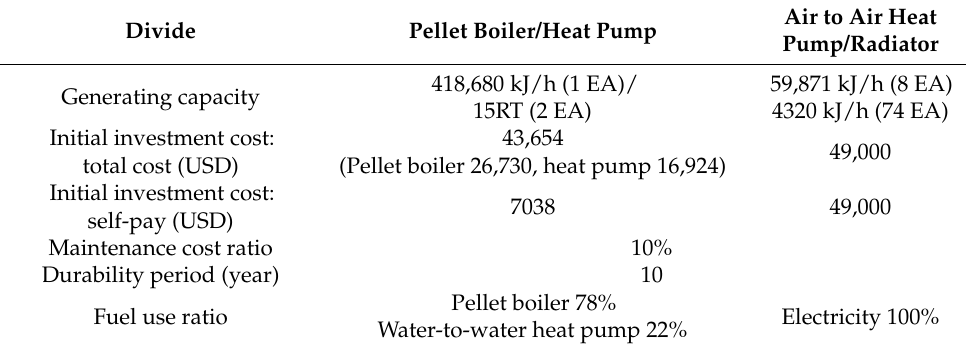
Table 7. Factors involved in the economic